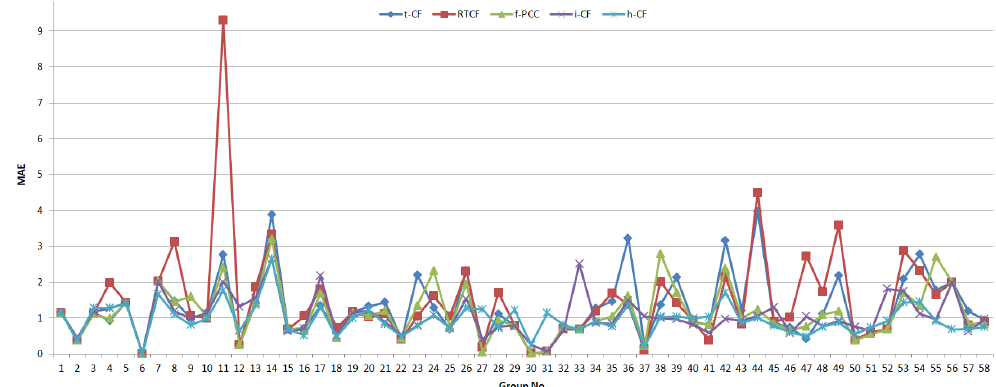
Figure 4. MAE (Mean Absolute Error) comparisons among the five methods based on the same 58 group target users.